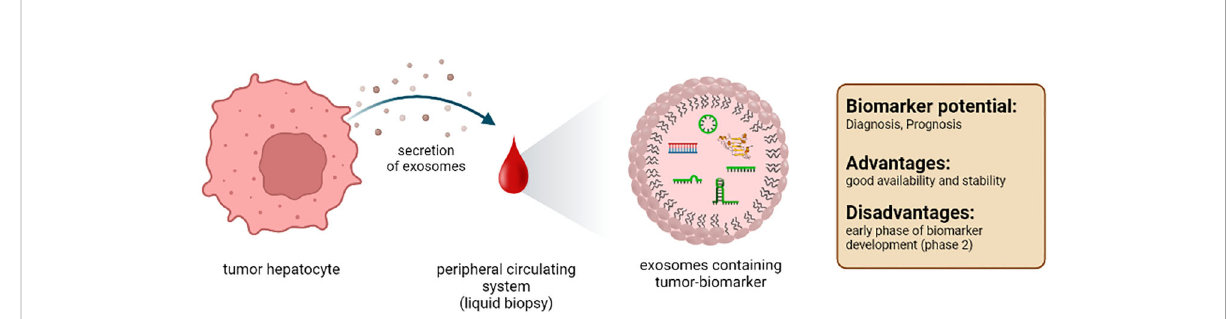
FIGURE 5 Characteristics of the biomarker class exosomes from a liquid biopsy in patients with